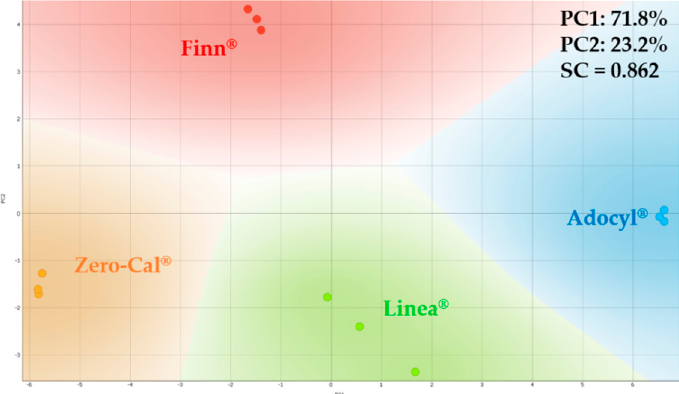
Figure 18. PCA plots for distinct brands of sucralose-based sweeteners in an espresso coffee matrix (10 µL/mL) obtained using the impedimetric microfluidic e-tongue under 5 mL/h flow rate.